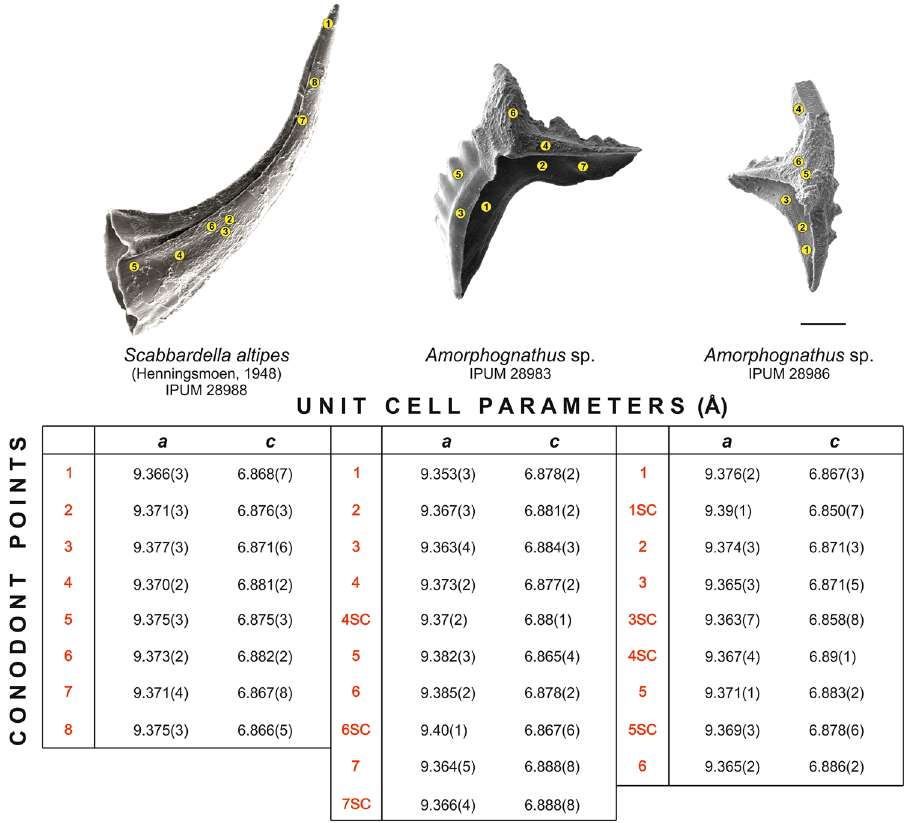
Figure 6. Unit cell parameters. Unit cell parameters (Å) obtained by μ XRD measurements on points of the surface of the three conodonts: Scabbardella altipes , specimen IPUM 28988, sample W-BK(C)-2006 (left element, analysed in eight points); Amorphognathus sp., Pb element, specimen IPUM 28983, sample W4-2006 (middle element, analysed in seven points); Amorphognathus sp., Pb element, specimen IPUM 28986, sample W-BK(C)-2006 (right element, analysed in six points). Standard deviations between parentheses. When not specified, points refer to polycrystalline apatite. SC = Single crystal. Point 4 in Amorphognathus sp. (right element) showed large columnar crystal microtextures and did not reveal polycrystalline-like diffraction signals. High standard deviations of unit cell parameters of some single crystals derive from a limited number of reflections obtained by μ XRD. Scale bar corresponds to 100 μ